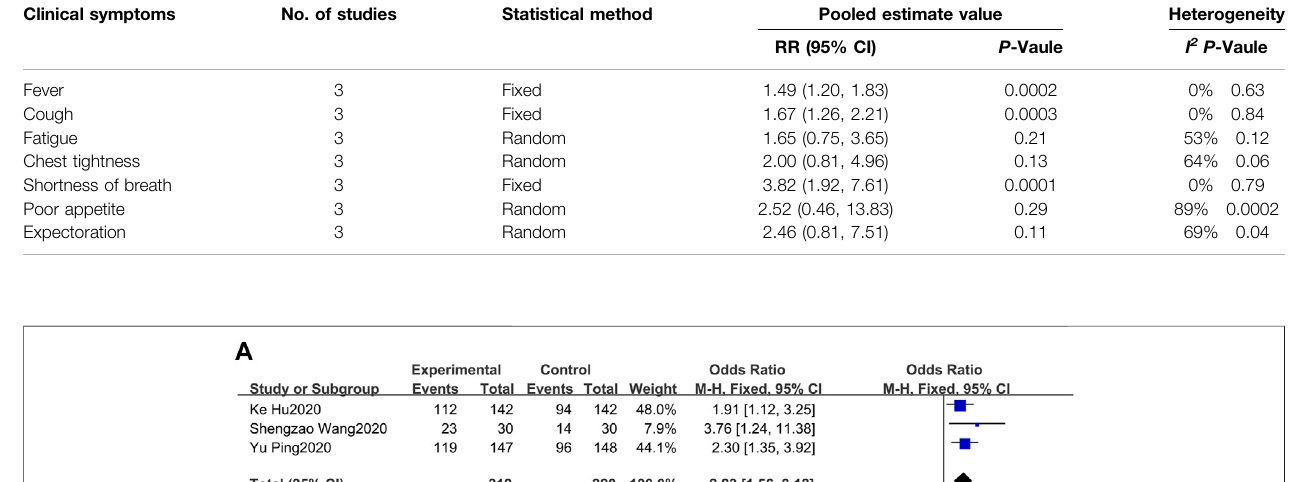
TABLE 2 | Comparison of the disappearance rate of clinical symptoms. Clinical symptoms